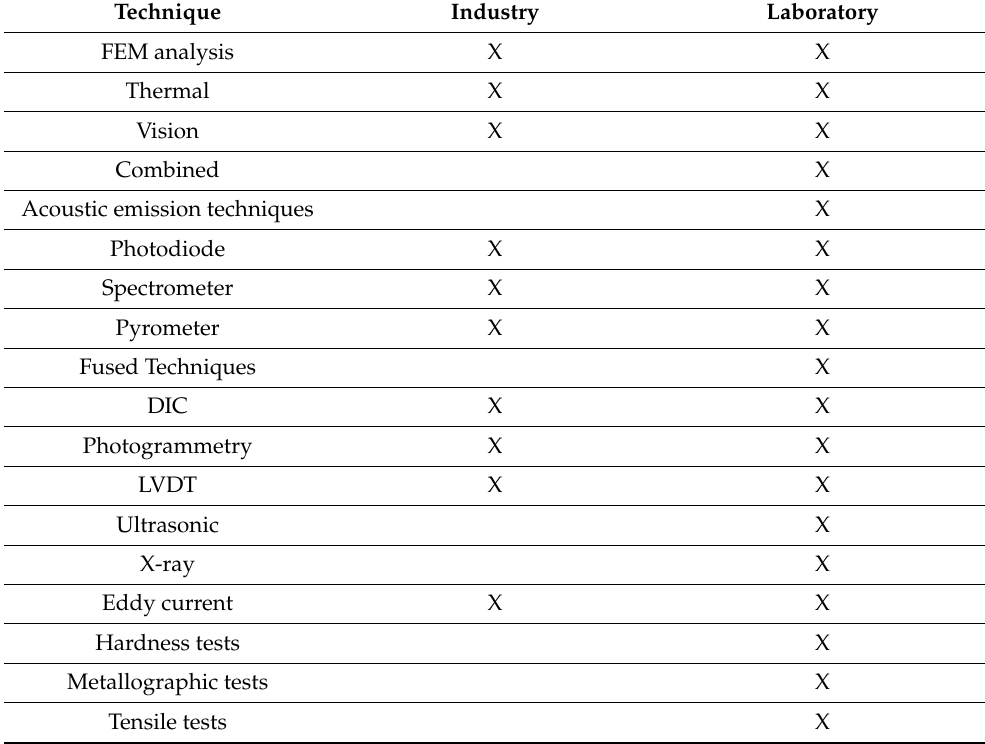
Table 6. Comparison of techniques (Industrial vs.